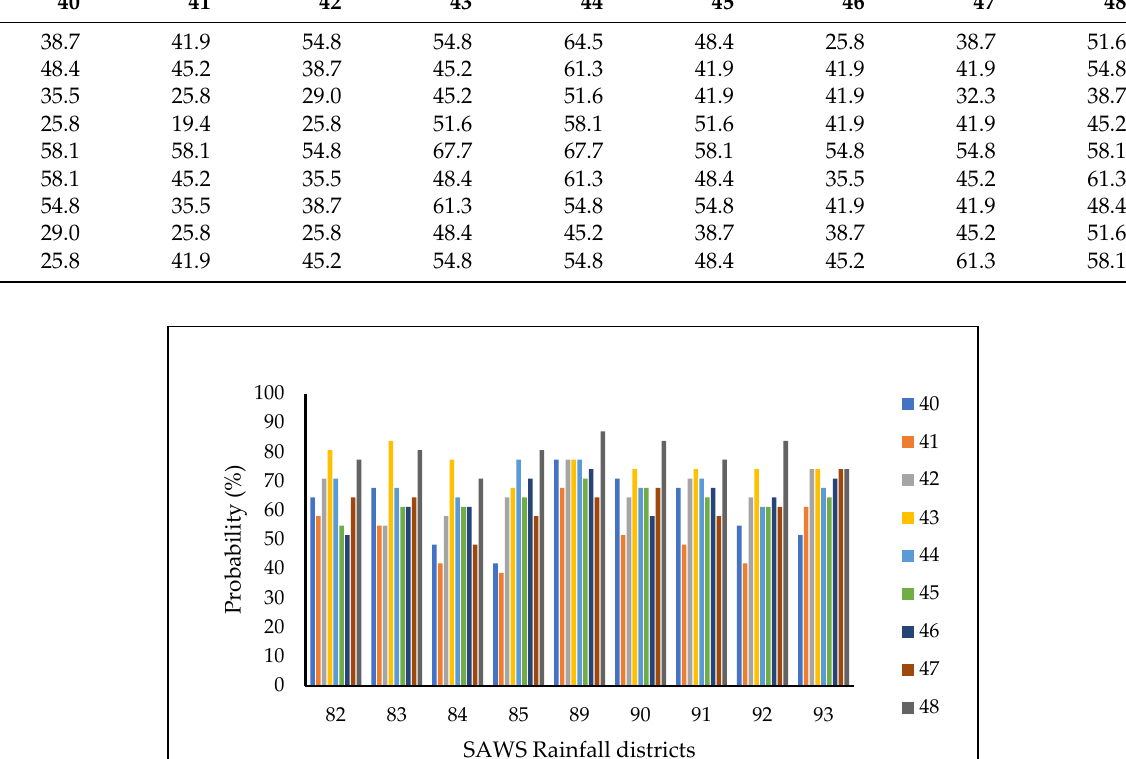
Figure 5. Probability of experiencing two consecutive dry ‐ spells for selected SAWS rainfall districts from 1985 to 2015 during pentads 40 to 48. The spatial analysis in Figures 6 and 7 shows that the dry ‐ spell and wet ‐ spell occur ‐ rences within the study area are erratic. In Figure 6, the spatial analysis of initial dry ‐ spell probability is shown for pentads 40, 44, 46 and 48. These pentads were selected because the 40th pentad is the first pentad of the analysis period, the 44th pentad has the highest probability, while the 46th pentad generally has an average probability, and, lastly, the 48th pentad is the end of the analysis period. For pentad 40, the highest initial dry ‐ spell probabilities were observed for the west and south ‐ western parts. High initial dry ‐ spell probabilities were also noticed in the north ‐ eastern part for pentad 44, in the western, north, and north ‐ eastern parts for pentad 46, and only the western area for pentad 48. For example, for pentad 44, the highest probability is 77% for districts 89 and 85, while dis ‐ tricts 84 and 92 have the lowest probability of 61%. This indicates that all districts experi ‐ enced dry ‐ spells. For pentad 46 (12–16 February), the highest probability of initial dry ‐ spell was 77%, and the lowest was 51%, with districts 85, 89 and 93 showing the highest initial probability and district 82 the lowest. For pentad 48 (22–26 February), the highest